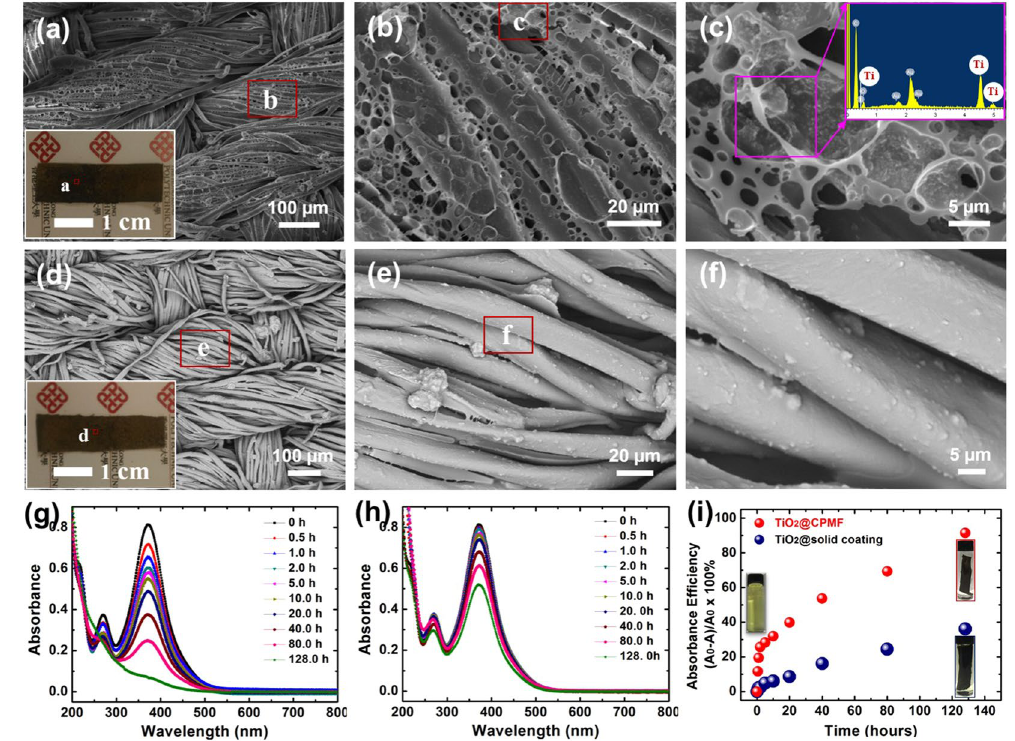
Figure 7. SEM images of ( a–c ) TiO 2 @CPMF and ( d–f ) TiO 2 @solid coated fabric at different magnifications. UV-visible spectral changes of MO1 aqueous solution (5 × 10 − 5 M) in the presence of ( g ) TiO 2 @CPMF and ( h ) TiO 2 @solid coated fabric with the exposure time of 365 nm UV irradiation. ( i ) The plot of removal efficiency of MO1 against time by different fabric-based samples. The insets of ( a ) and ( d ) were the photographs of 1 cm × 4 cm TiO 2 @CPMF and TiO 2 @solid coated fabric, respectively. The insets of ( i ) were the photographs of as- prepared MO1 aqueous solution and the MO1 aqueous solutions filled with different modified fabrics after 128 h UV irradiation time,